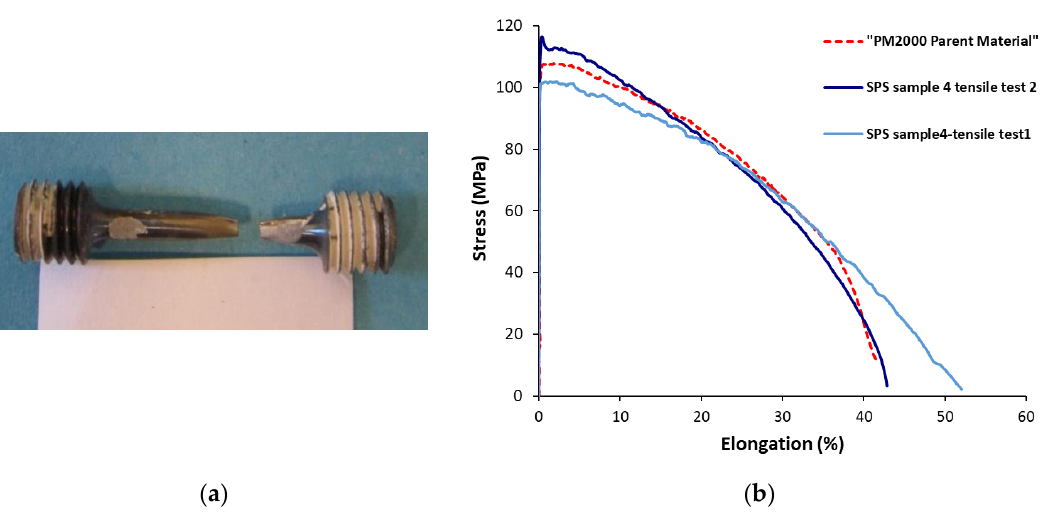
Figure 11. ( a ) Feature photographs of cylindrical tensile specimen (Sample 4-tensile test 2) following mechanical testing alongside ( b ) stress–strain curves at 750 °C for Sample 4 (cylindrical and flat samples) and the base PM2000 alloy in the as-received state.